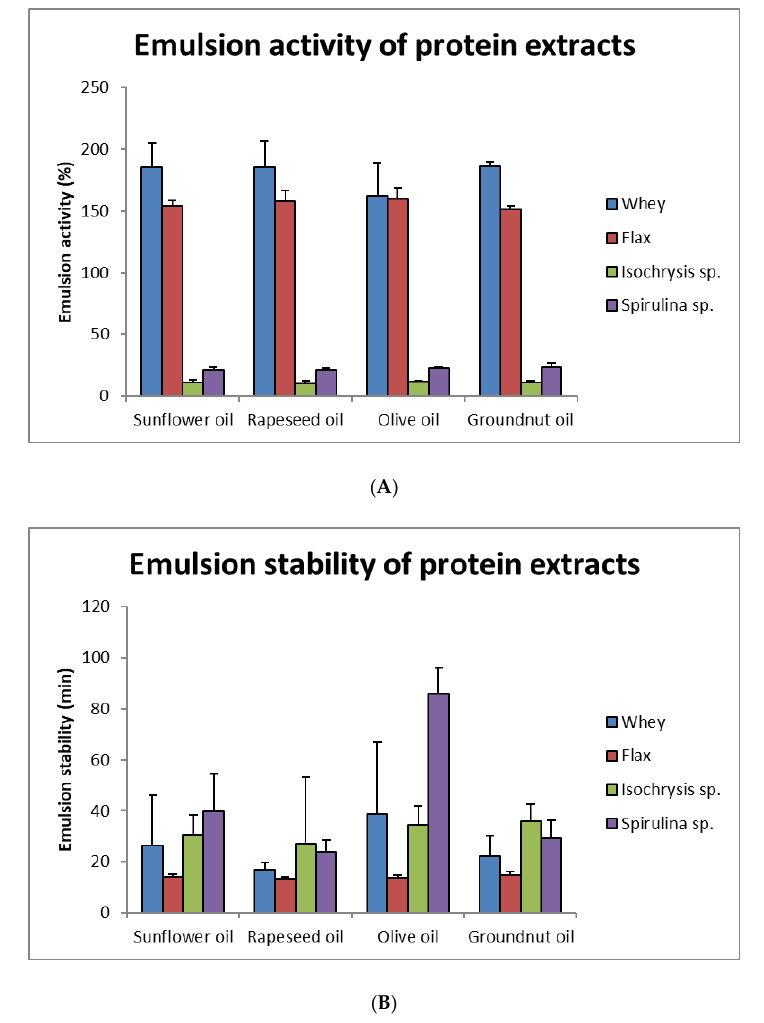
Figure 5. ES ( A ) and EA ( B ) of soluble protein extracts (n = 3). Values calculated against